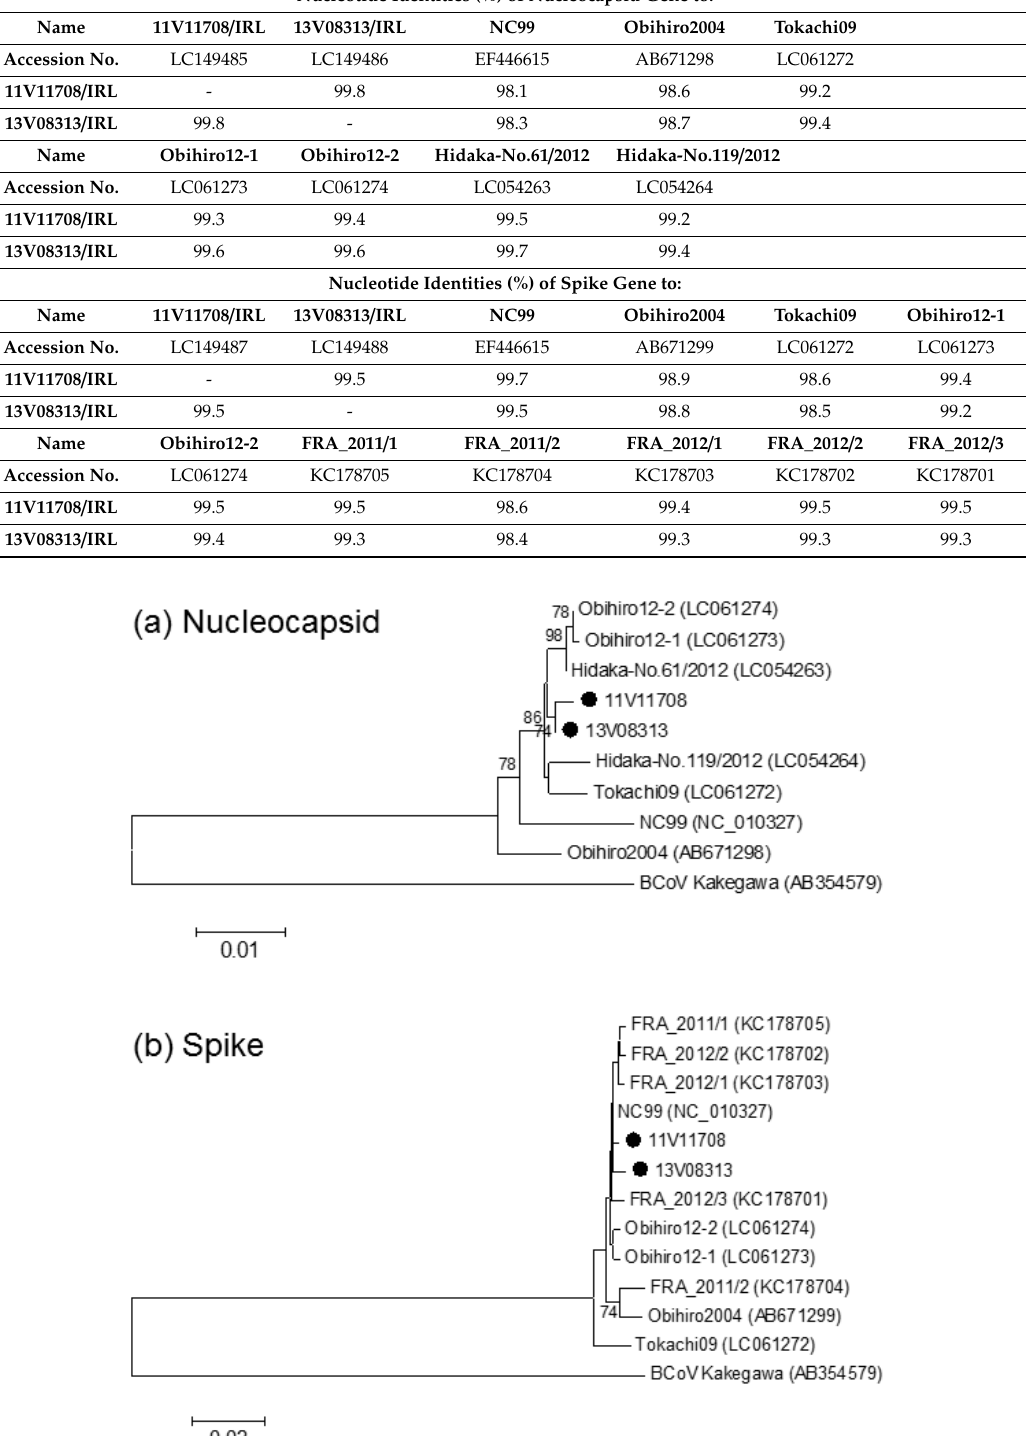
Table 2. Nucleotide sequence identities of Irish ECoVs and ECoVs from other continents. Nucleotide Identities (%) of Nucleocapsid Gene to: